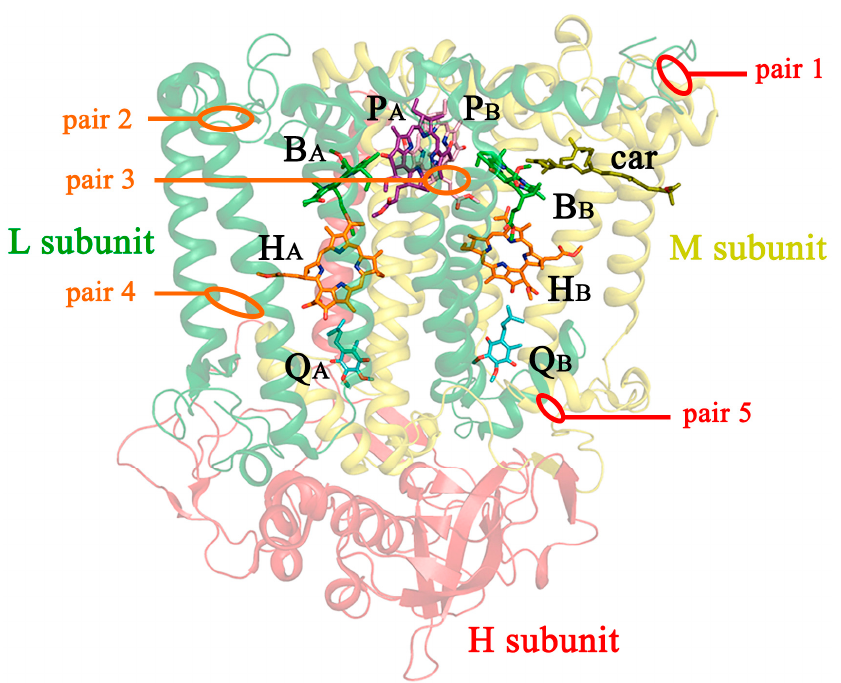
Figure 1. Locations of cysteine substitutions in the C. sphaeroides RC complex. Pairs of mutations within the subunit and between subunits are shown in orange and red, respectively. P A and P B are BChls of the special pair; B A and B B are monomeric BChl; H A and H B are monomeric BPheo; Q A and Q B are ubiquinones; car is a carotenoid. In this model, the tails of the cofactors are